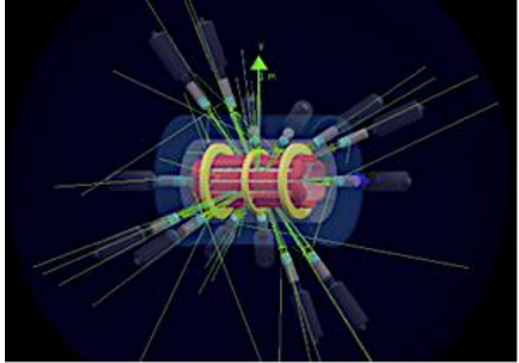
Fig. 3 – Render view of the experimental setup showing the magnetic trap, the HPGe detectors and the GEANT4 ray tracing simulations of the γ